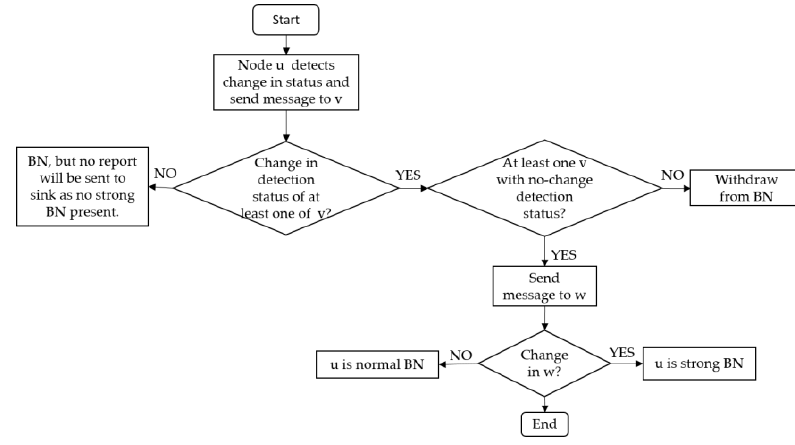
Figure 4. Flow diagram of the BN selection process .